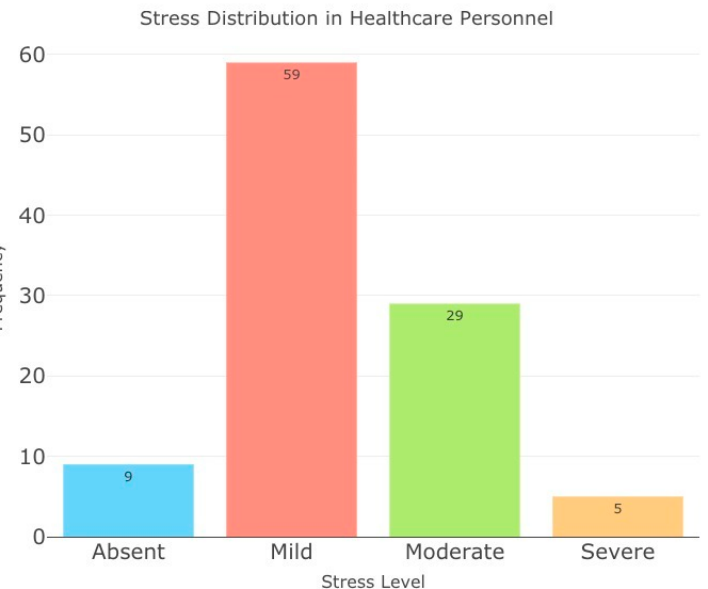
Figure 2. Stress level distribution in healthcare personnel. (Left to right) Absent, Mild, Moderate, Severe .